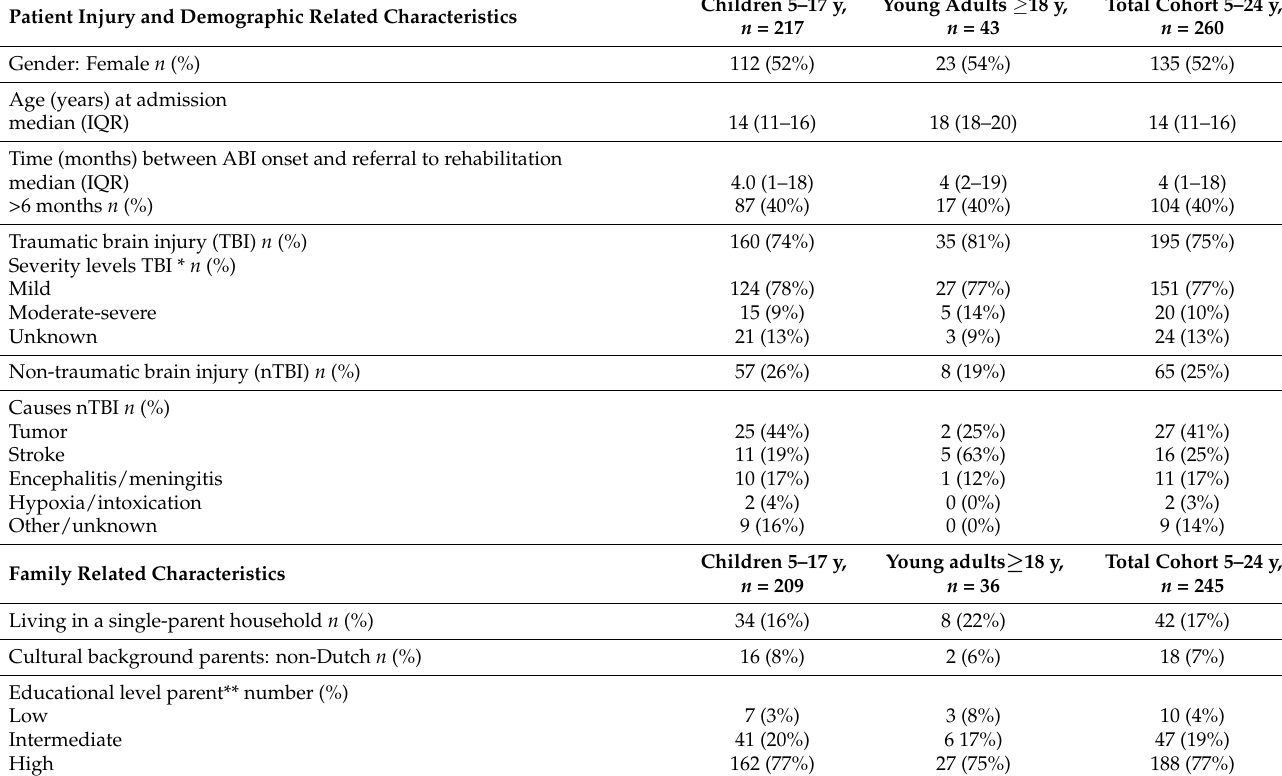
Table 1. Patient, family and injury characteristics of children and young adults with acquired brain injury (ABI) referred to an outpatient rehabilitation